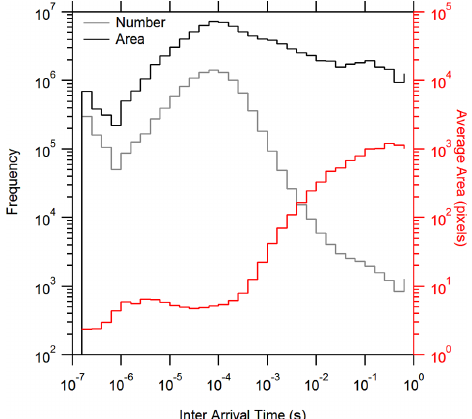
Fig. B1. Frequency histograms of particle interarrival time from the 2DS measured during flight B430. The “Number” curve (gray – weighted by number) and the “Area” curve (black – weighted by particle area) are plotted on the left axis. Average particle area is plotted in red on the right